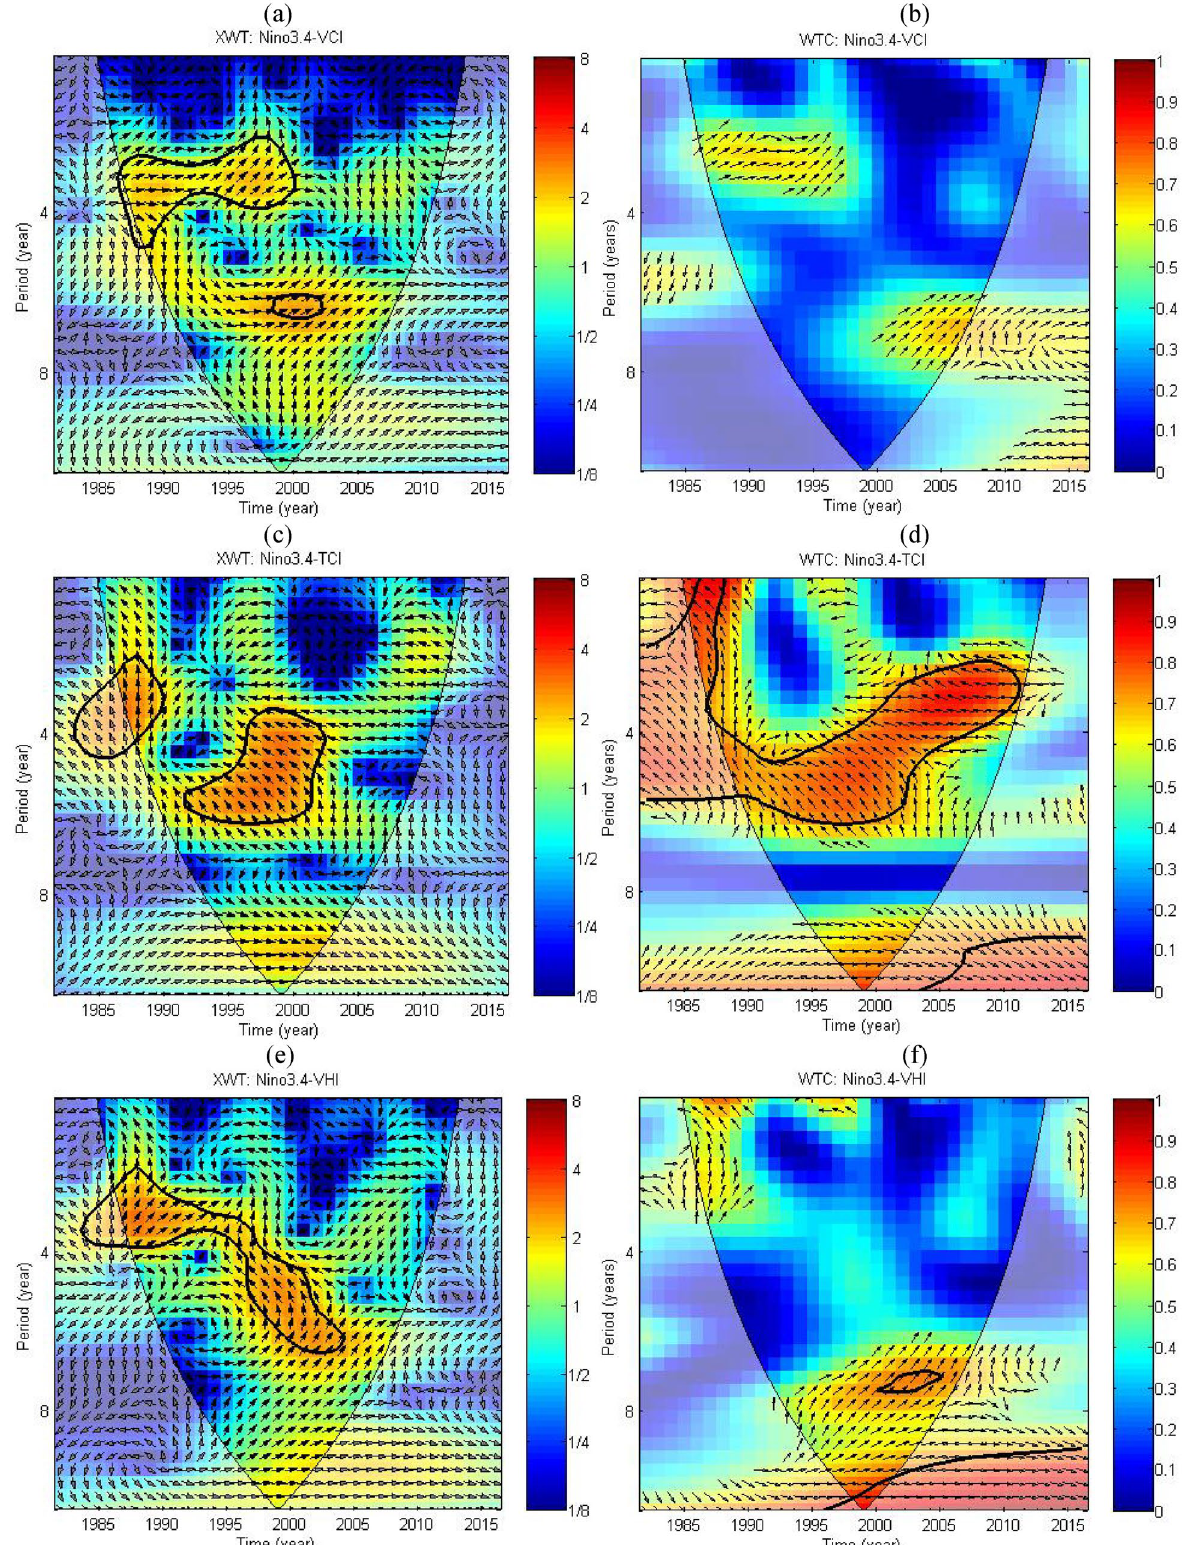
Figure 8. Cross wavelet transform and wavelet coherence between Niño 3.4 and regional average VCI ( a , b ), TCI ( c , d ), and VHI ( e , f ) during growing season for the period of 1982–2016 in Jing-Jin-Ji region. The sag dashed line draw through the wavelet spectrum is the cone of influence, and the thick enclosed areas indicate statistically significant wavelet coherence at a 5% significance level against a red noise. The arrows indicate the phase difference of period and coherence that are bigger than 0.5 between Niño 3.4 and regional average VCI. Left (right) pointing arrows indicate anti (in) phase coherence. The figures were created using Cross Wavelet and Wavelet Coherence Toolbox (http:// grins ted. github. io/ wavel et- coher